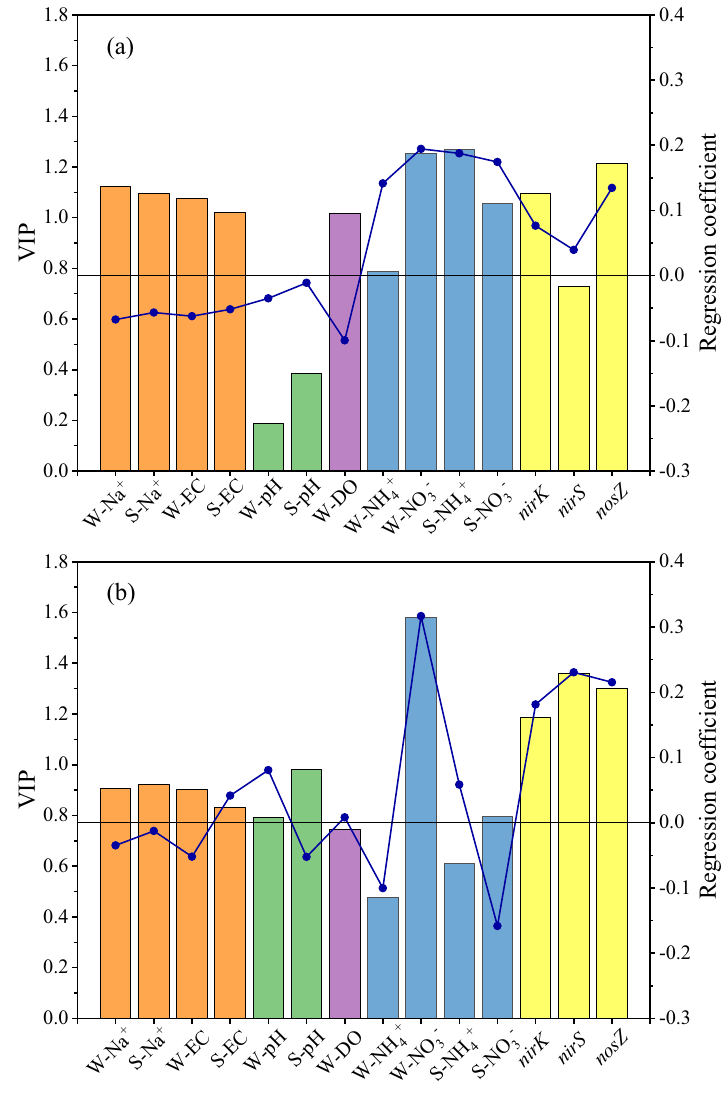
Figure 6. Variable importance for the projections (bars) and regression coefficients (lines) for each predictor of denitrification rates in a saline environment ( a ) and a saline-alkali environment ( b ). VIP, variable importance in prediction. “W-” and “S-” indicate the overlying water and sediment,